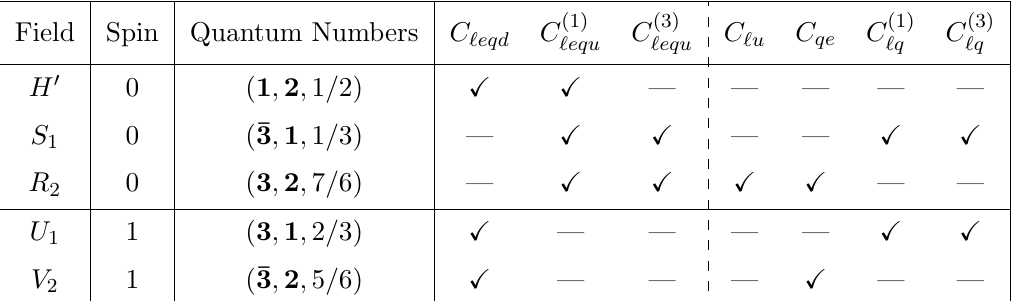
Table 3 . Classi(cid:12)cation of the particle (cid:12)elds that can generate the operators (3) by tree-level matching, in terms of the SM quantum numbers, (SU(3) c ; SU(2) L ; Y ), with ‘equ O Q = Y + T 3 as hypercharge convention. For completeness, we also list the other semileptonic operators generated by these scenarios in the Warsaw basis [52,